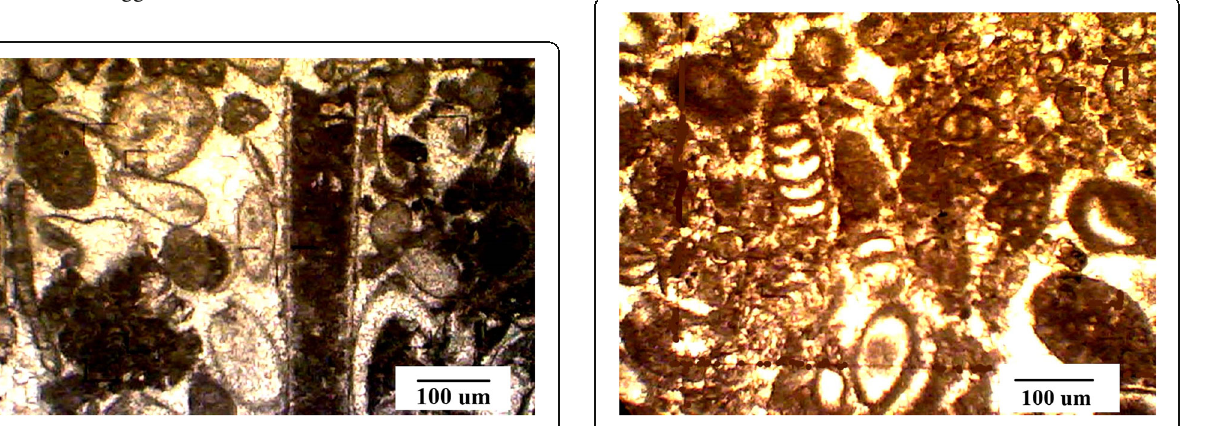
Fig. 8 Nummulitic rudstone microfacies showing the fossils are mostly filled with sparry calcite, but a few miliolids and algae are micritized and have a micritic envelope. Note: Compaction and the micritic envelope, PPL